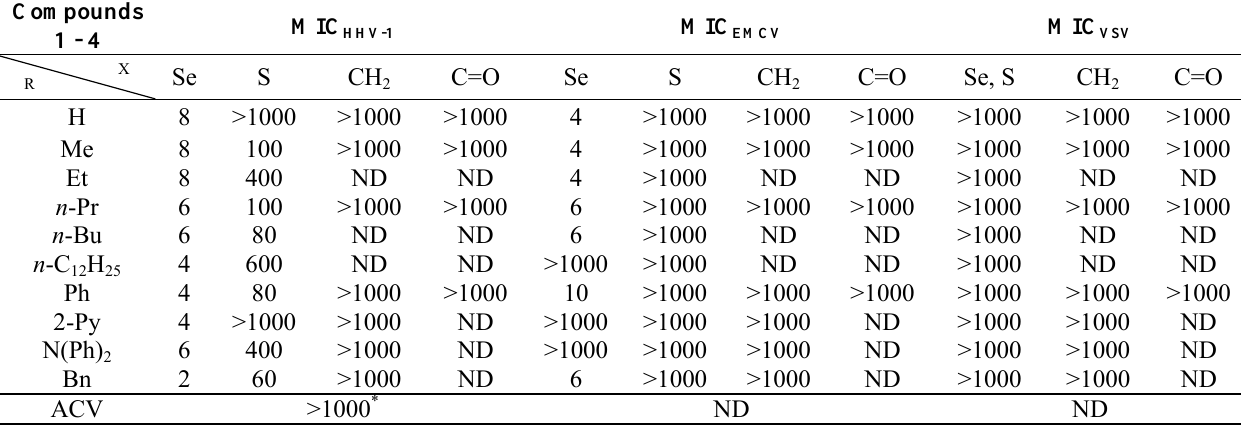
Table 1. Comparison of the virucidal activity of benzisoselenazol-3(2 H )-ones 1 and their isostructural analogues 2 – 4 .